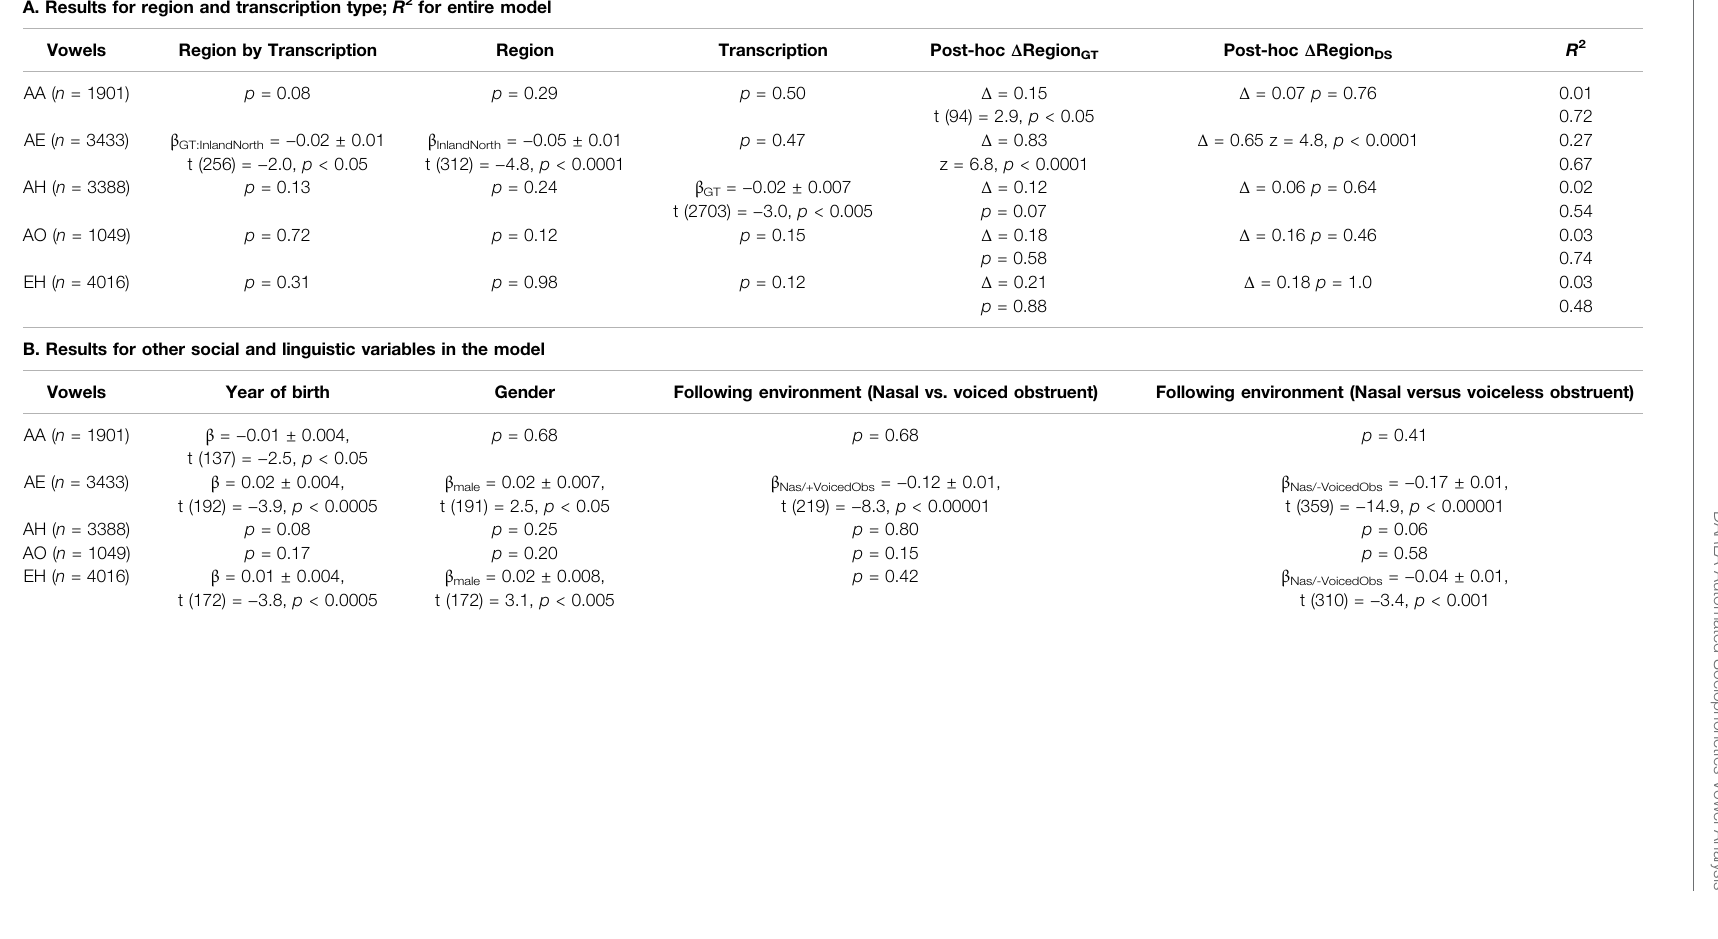
TABLE 4 | LMER models for the Northern Cities Shift. The dependent variable is F2 for THOUGHT (AO), LOT (AA) and STRUT (AH), and F2-2xF1 for TRAP (AE) and DRESS (EH). R 2 shows the marginal and conditional coef fi cients. Deltas show the difference between the mean position of the Southern vowel and the mean position of the Northern vowel for each transcription type: AA shows divergence in GT/DS results; for the other vowels, either both models detect a difference between Inland and General North or they do